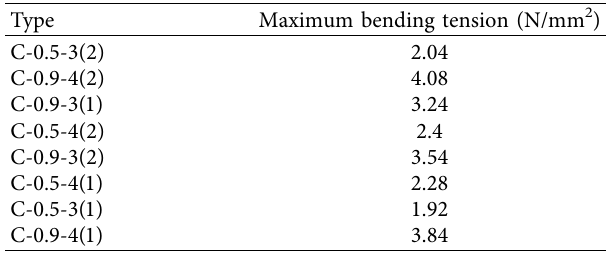
Figure 9: The tension-displacement diagram in the axial test for 4 composite panels filled with foamed concrete. Table 5: The bending test results for 8 foamed concrete panels.